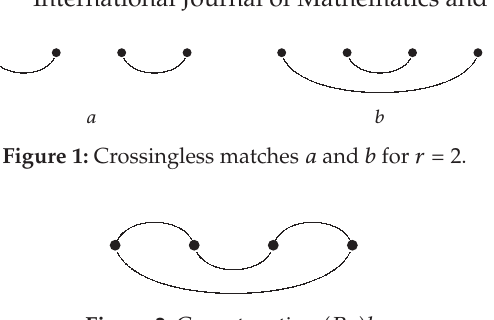
Figure 2: Concatenation (cid:2) Ra (cid:3) b